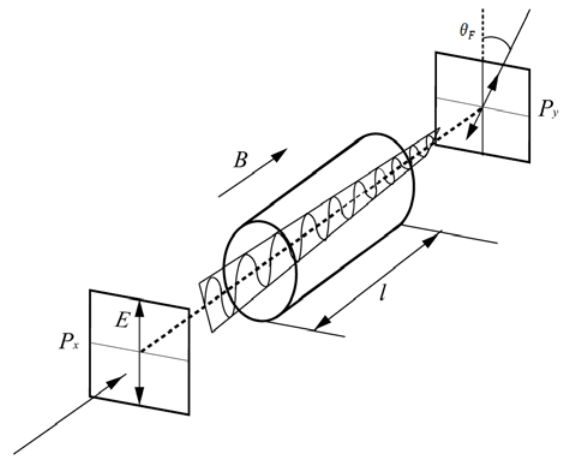
Figure 2. Faraday e ff ect Figure 2. Faraday effect schematic.